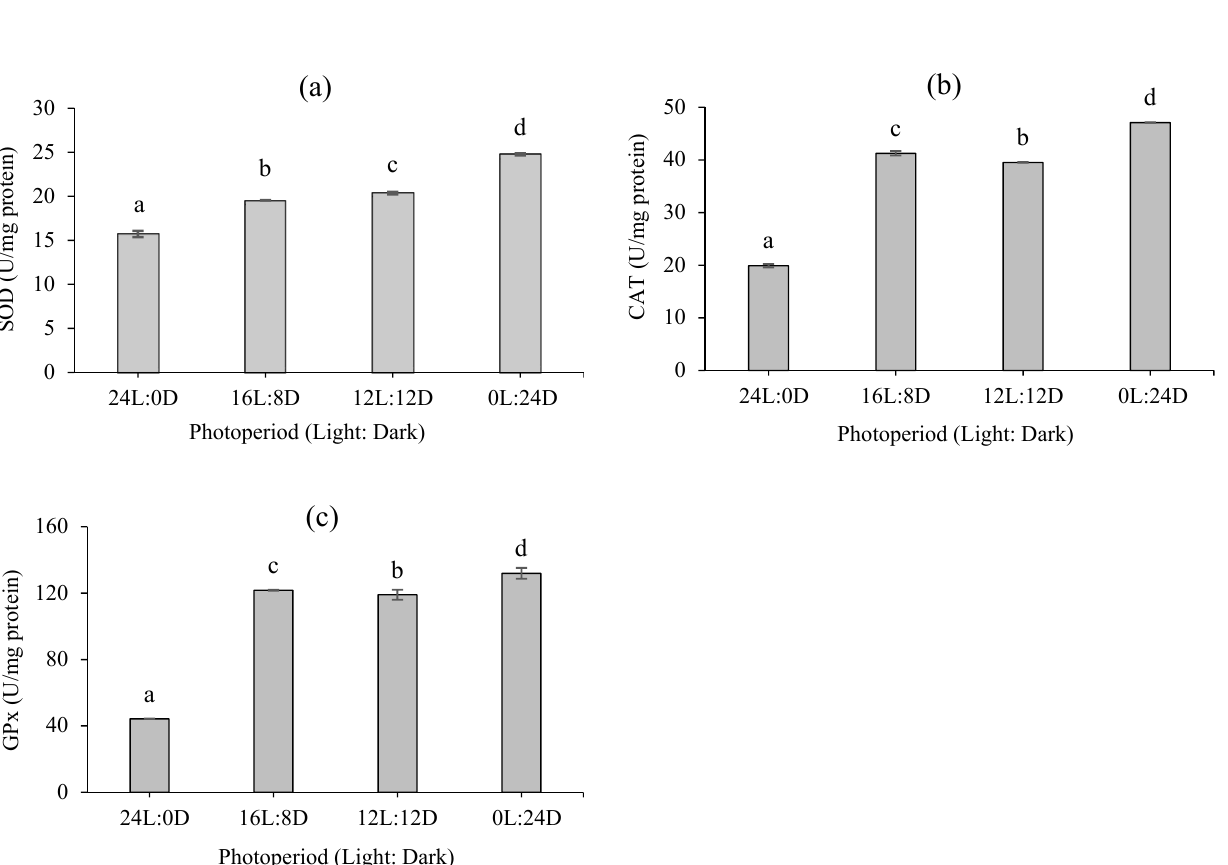
8 of 16 Figure 3. Effect of different photoperiods on digestive enzyme activity of B. orientalis at the end of the experimental period (mean ± SD, n = 3): ( a ) alkaline protease (AP), ( b ) alpha-amylase (AA), ( c ) lipase (LP), and ( d ) soluble protein content (SPC). Different superscript letters denote statistically significant differences at p < 0.05. 3.4. Antioxidant Status